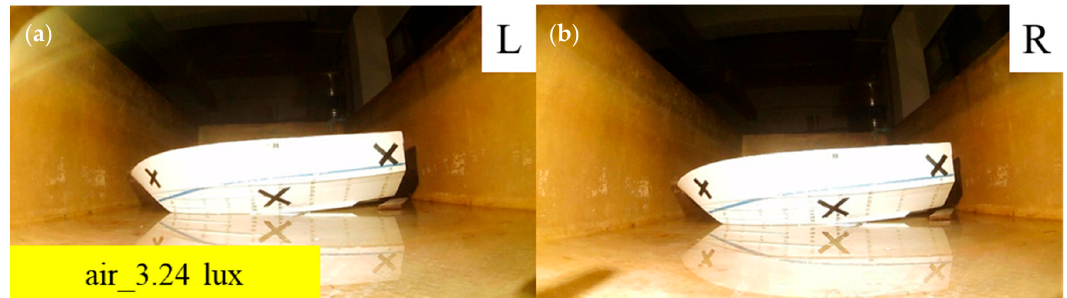
Figure 20. Images captured by ( a ) left and ( b ) right lenses under 3.24 lux illuminance and the out-of-water environment ( d = 1 m).